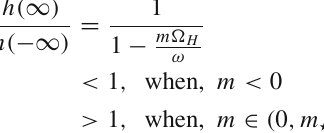
be noticed that one can get the bound on the greybody factor for m = 0 case(the expression obtained by putting the result of Eq. (28) in Eq. (26)) from these bounds of Eq. (33) and Eq. (34) by simply making m = 0 in these expressions. Here the contribution of non zero m comes through specific two quantities in the bound, and they also contain the effect of the deformation parameter η for m (cid:5)= 0. In Fig. 9 we have plotted this bound with respect to varying η for fixed param- eters l = 2, m = − 1, a = 0 . 05 and different values of the frequency ω . Note here we have kept the quantity a ω (cid:4) 1 so that the approximation of Eq. (17) can be made. From this figure also one can observe that the bound on the greybody factor increases with an increasing value of the deformation parameter and mode